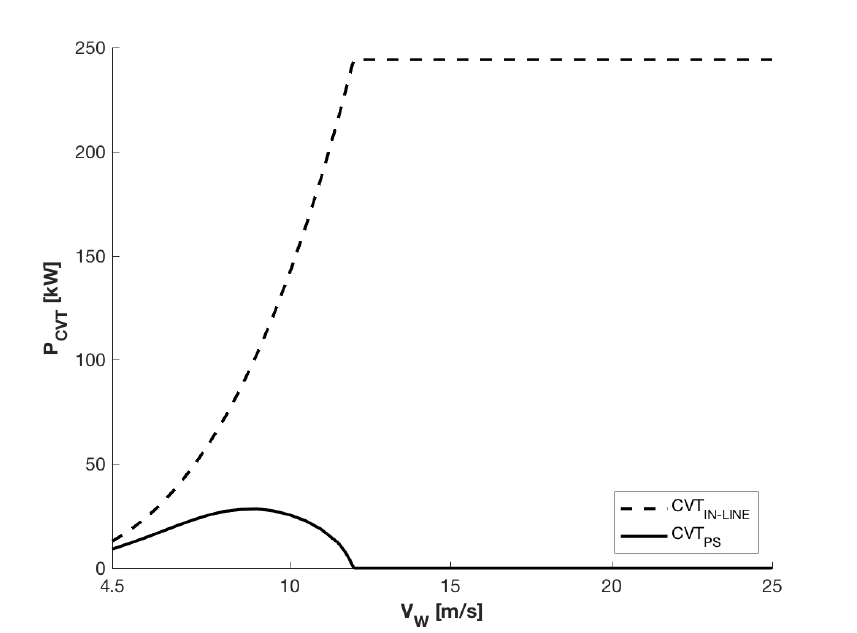
Figure 7. Power across the hydraulic Continuously Variable Transmission (CVT) in the in-line HTS and in the PS-HTS.